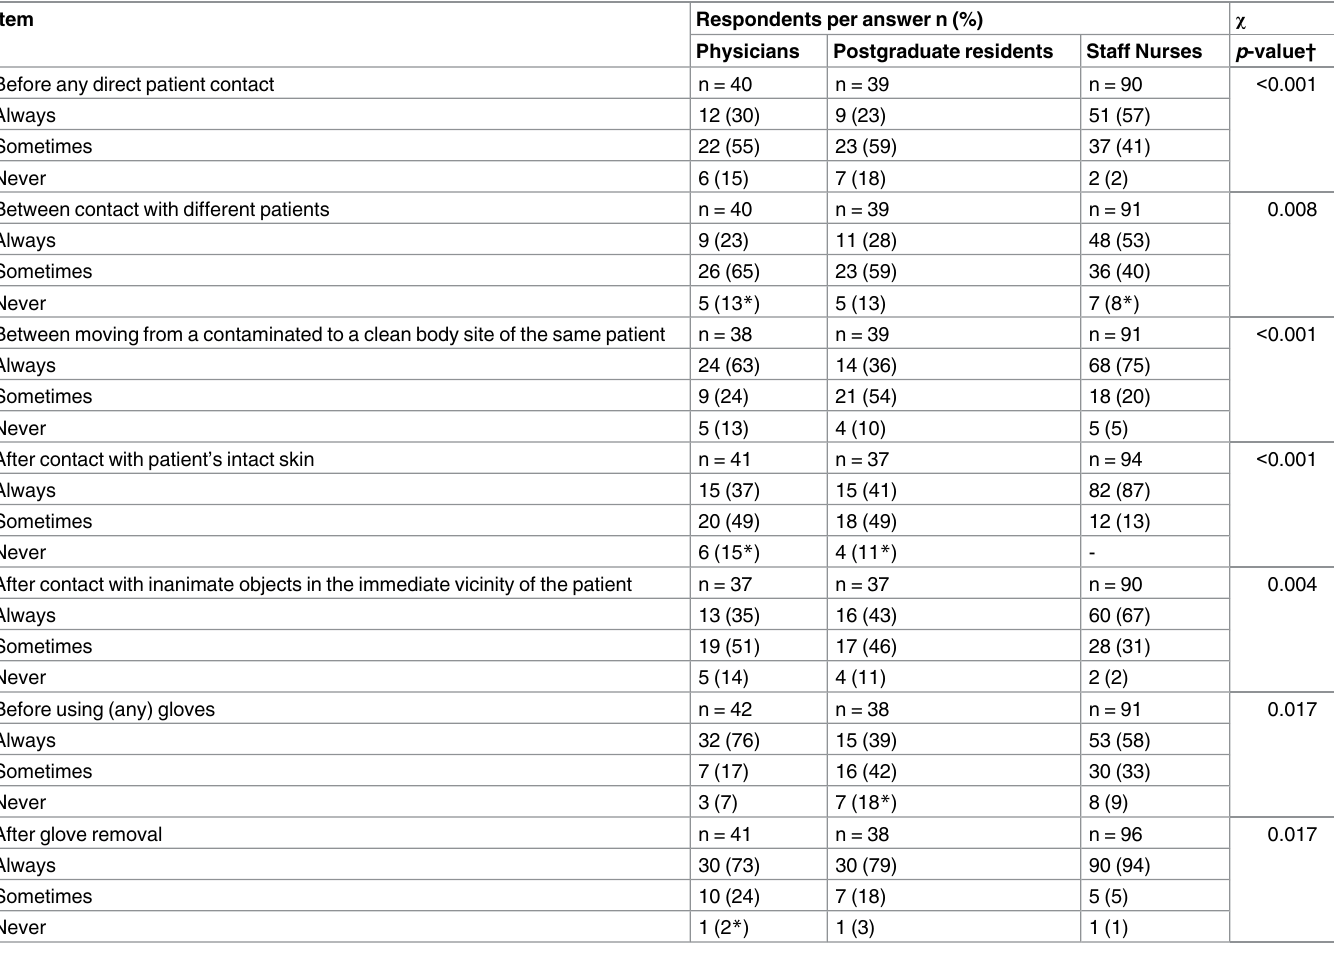
Table 3. Self-reported hand hygiene practice according to respondent study groups (DPC respondents) in study